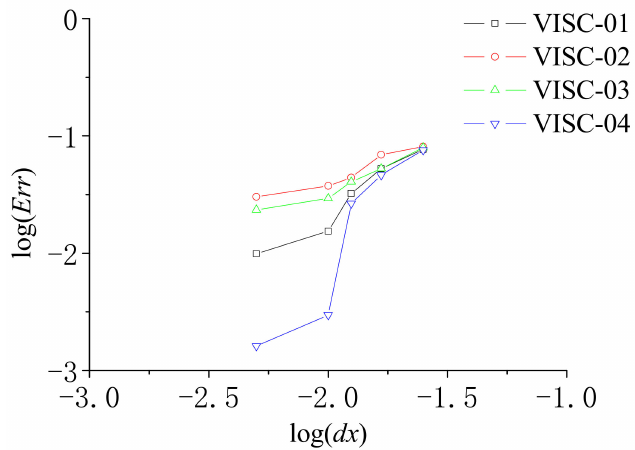
Figure 14. Convergence and error analysis of four viscosity force models for the different particle resolutions of a lid-driven flow with an inside